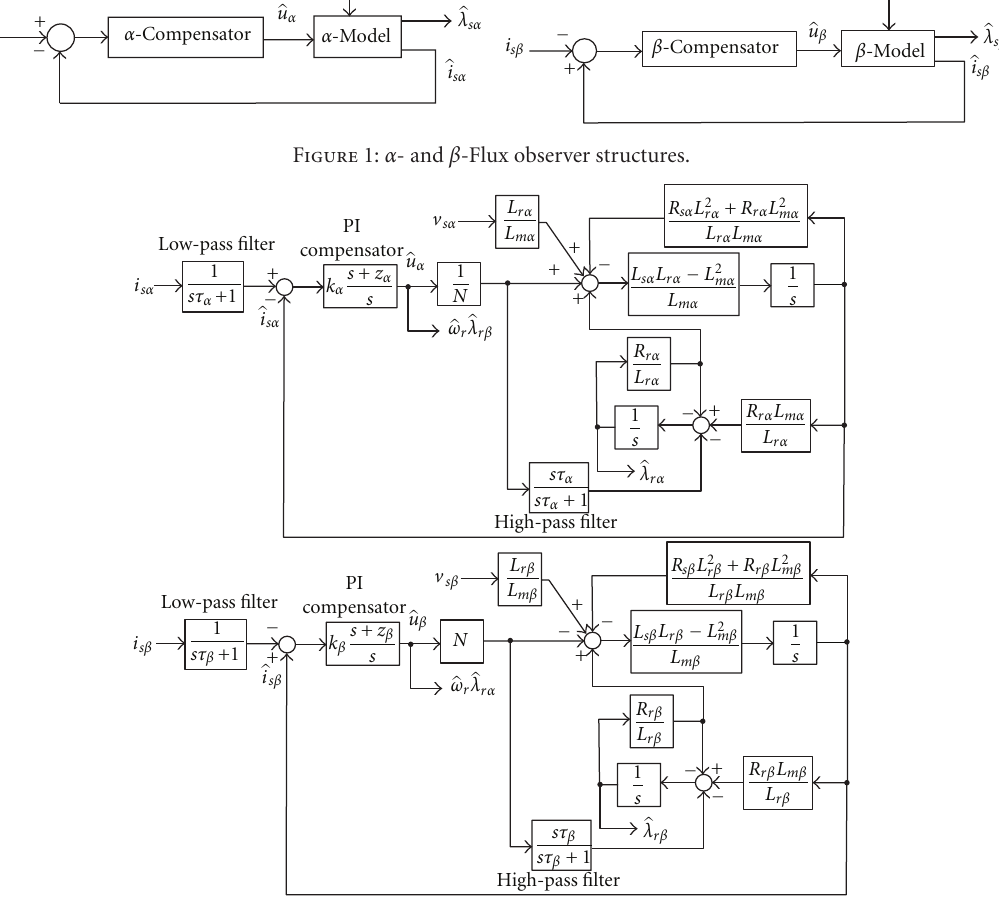
Figure 2: Block diagram of α - and β -flux